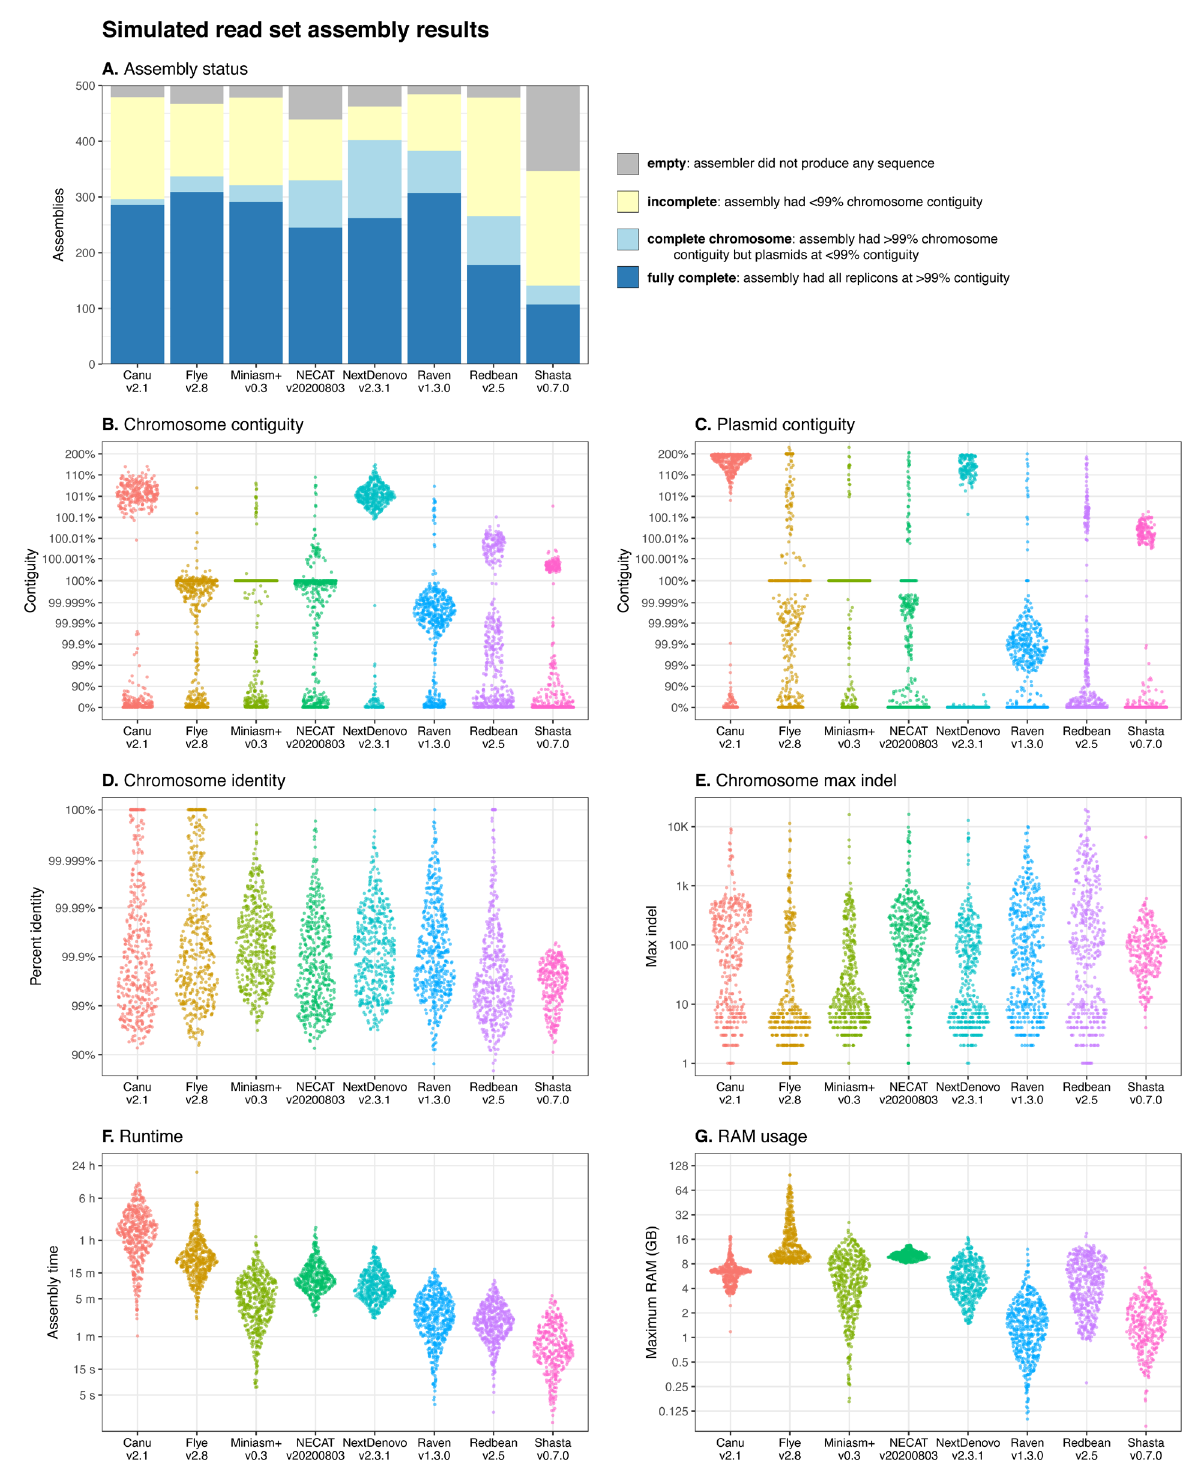
Figure 1. Assembly results for the simulated read sets, which cover a wide variety of parameters for length, depth and quality. ‘Miniasm+’ here refers to the entire Miniasm/Minipolish assembly pipeline. ( A ) Proportion of each possible assembly outcome. ( B ) Relative contiguity of the chromosome for each assembly, showing cleanliness of circularisation. ( C ) Relative contiguity of all plasmids in the assemblies, showing cleanliness of circularisation. ( D ) Sequence identity of each assembly’s longest alignment to the chromosome. ( E ) The maximum indel error size in each assembly’s longest alignment to the chromosome. ( F ) Total time taken (wall time) for each assembly. ( G ) Maximum RAM usage for each assembly.